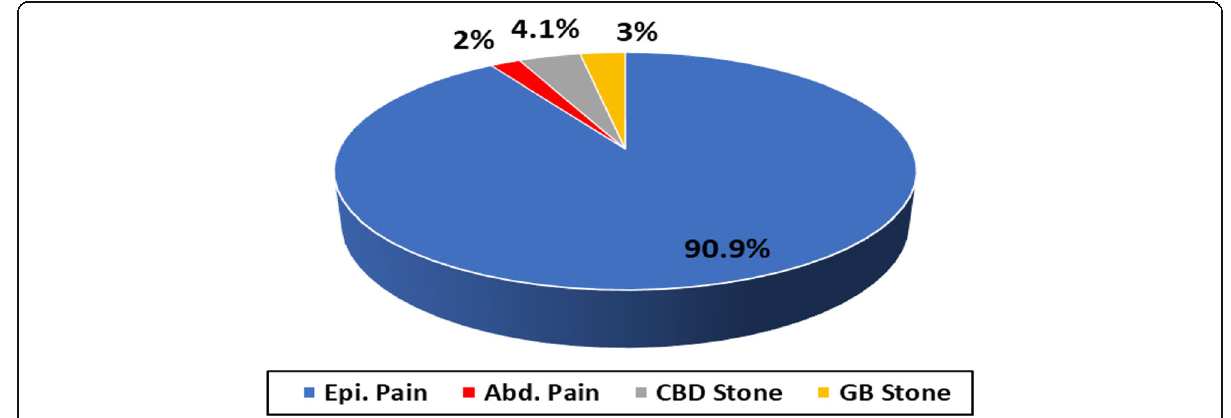
Fig. 4 Distribution of the sample according to the main presenting